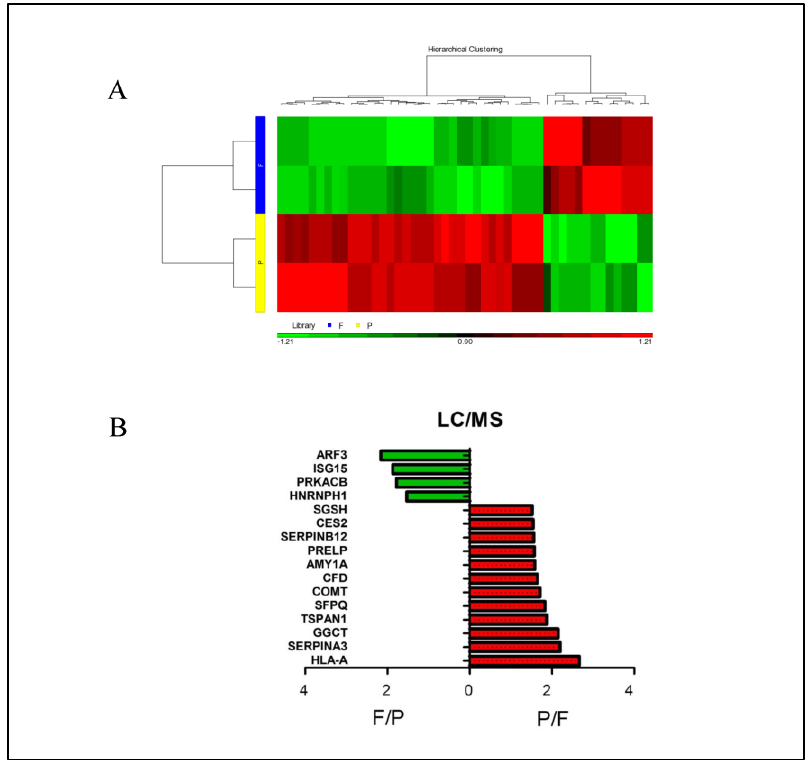
Figure 3. Differential salivary proteins between Streptococcus pneumoniae (P) and influenza A virus (F) groups. ( A ) Heat map was obtained by comparing the 47 differentially expressed proteins identified by gel-free iTRAQ proteomics analysis. The picture is colored according to the abun- dance: green and red represent relatively low and high abundance, respectively. ( B ) Ranking of proteins by abundance more than 1.5-fold, 4 proteins were more abundant in the influenza A group, and 12 proteins were more abundant in the Streptococcus pneumoniae group. Abbreviations: ARF3, ADP-ribosylation factor 3; ISG15, Interferon-stimulated gene 15; PRKACB, cAMP-dependent pro- tein kinase catalytic subunit beta; HNRNPH1, heterogeneous nuclear ribonucleoprotein H1; SGSH, n-sulphoglucosamine sulphohydrolase; CES2, carboxylesterase 2; SERPINB12, serpin family B mem- ber 12; PRELP, prolargin, AMY1A, alpha-amylase 1; CFD, complement factor D, COMT, catechol- O-methyltransferase; SFPQ, splicing factor, proline- and glutamine-rich; TSPAN1, tetraspanin 1; GGCT, gamma-glutamylcyclotransferase, SERPINA3, alpha 1-antichymotrypsin, and HLA-A, human leukocyte